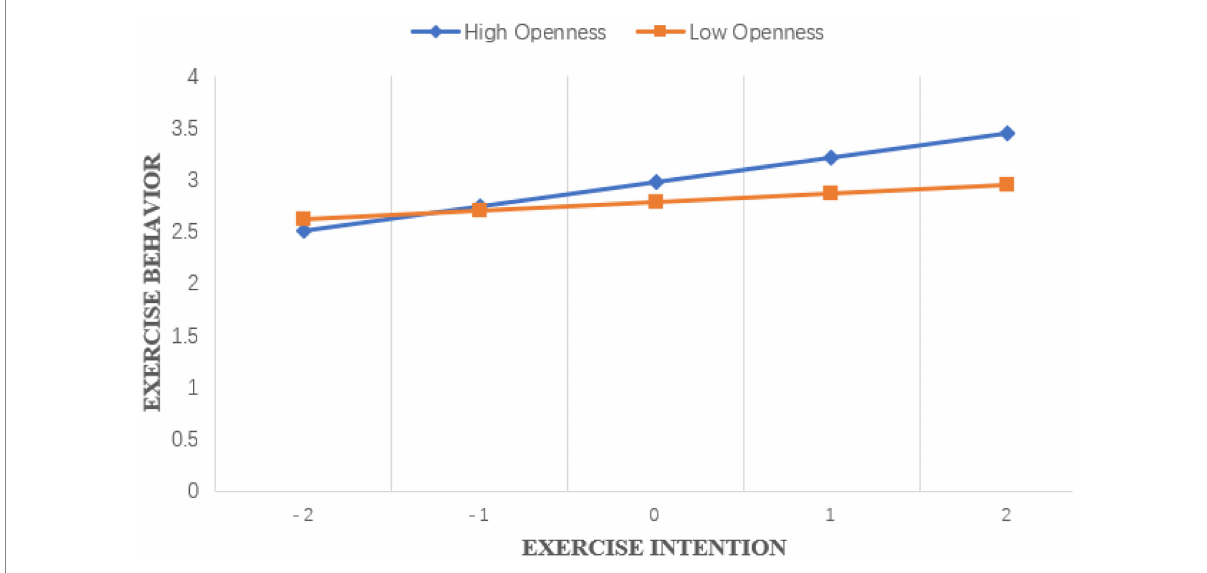
FIGURE 2 The moderating effect of openness on exercise behavior and exercise intention.